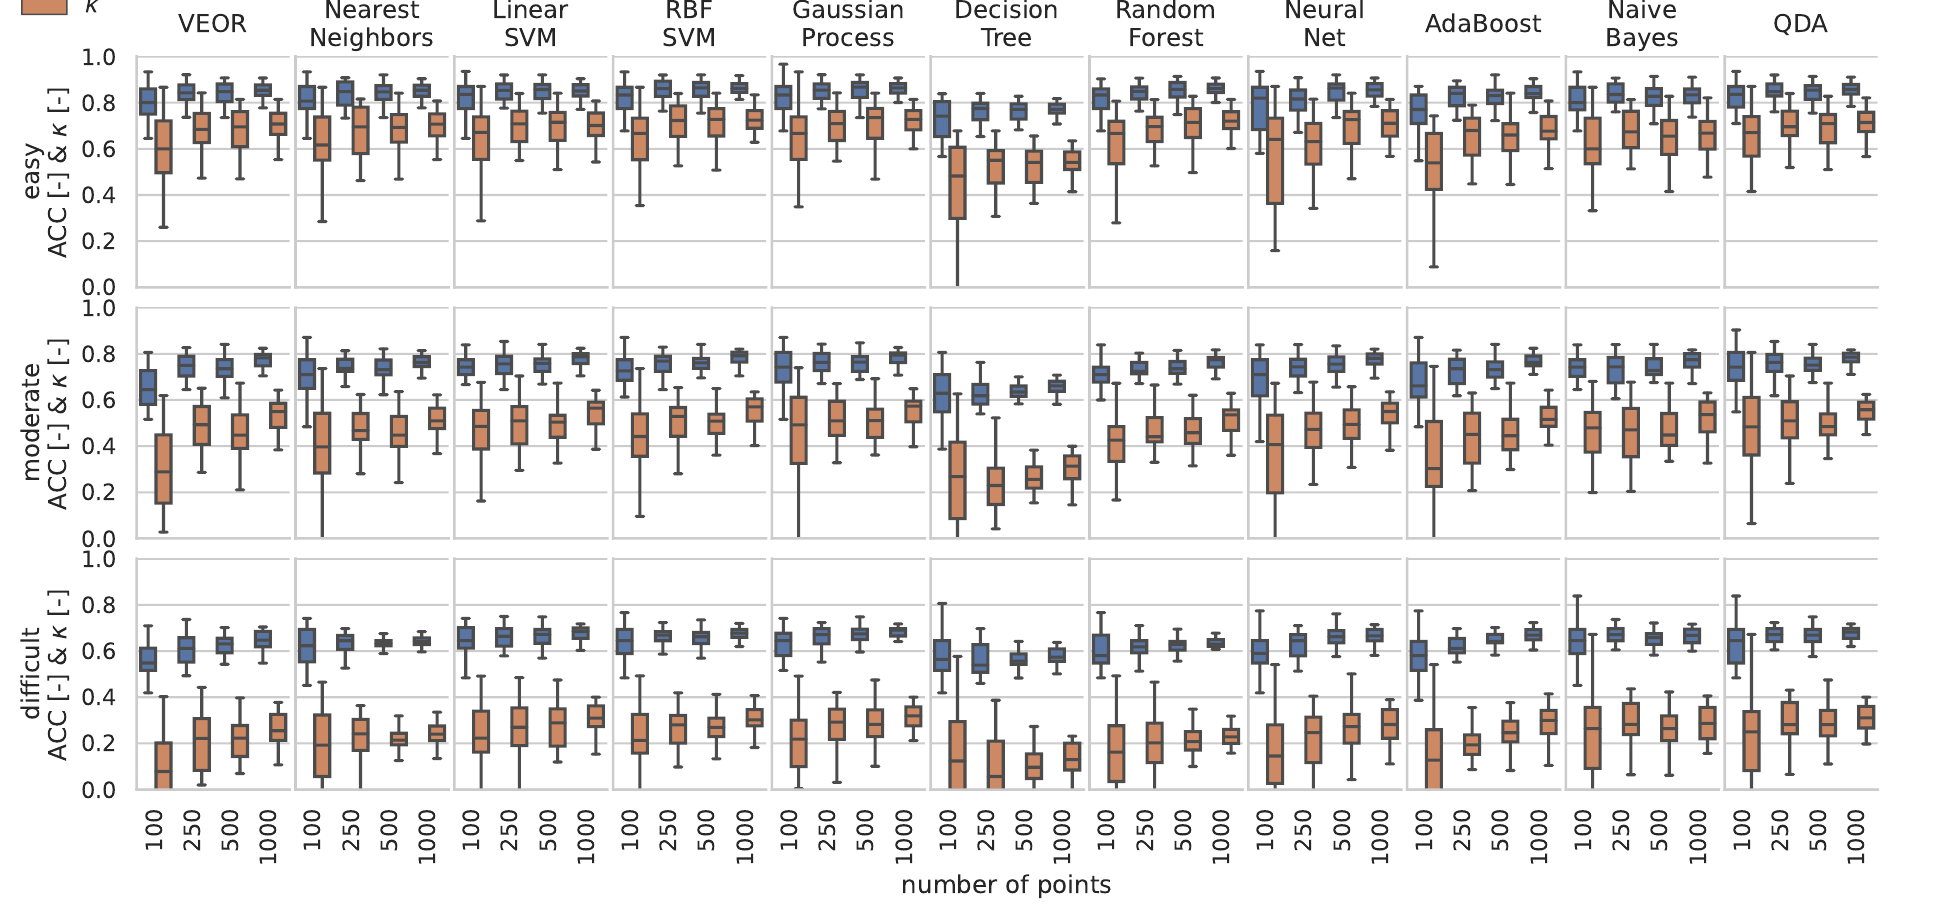
Figure 6. Summary of experiments with 7D datasets grouped according to classification difficulty. Easy datasets feature 10% of mislabeled samples and a 50%/50% class balance; moderate datasets feature 20% of mislabeled samples and a 40%/60% class imbalance; difficult datasets feature 30% of mislabeled samples and a 30%/70% class imbalance. Each experiment was repeated 30 times with randomly generated